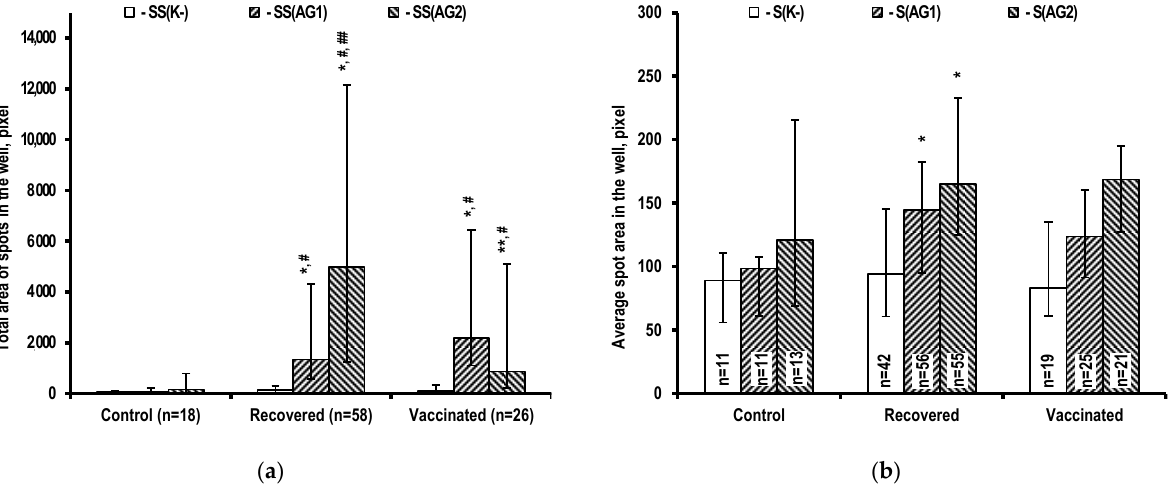
Figure 2. IFN ‐γ production intensity by PBMCs in the examined individuals. ( a ) Total spot area per well without stimulation (SS(K − )) and with specific stimulation using various sets of antigens (SS(AG1), SS(AG2)). ( b ) Mean spot area per well (wells without spots were excluded from analysis) without stimulation (S(K − )) and with specific stimulation using various sets of antigens (S(AG1), S(AG2)). * p < 0.01 when compared to controls using the same parameter. ** p < 0.01 when compared to recovered individuals using the same parameter. # p < 0.01 when compared to non ‐ stimulated PBMCs within a group. ## p < 0.01 when comparing PBMCs stimulated with various sets of antigens within a group.